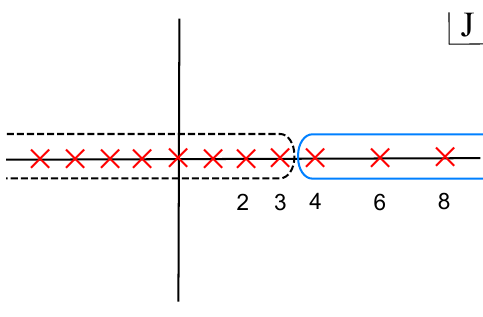
Figure 1 . Contour and the deformed contour in the complex J